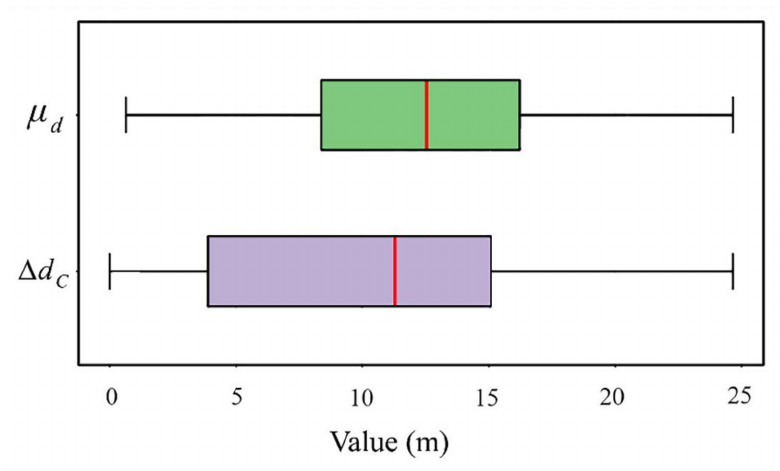
Figure 16. Boxplots of average zonal building displacement amounts ( µ d ) and zonal displacement amounts of building group centroids ( ∆ d C